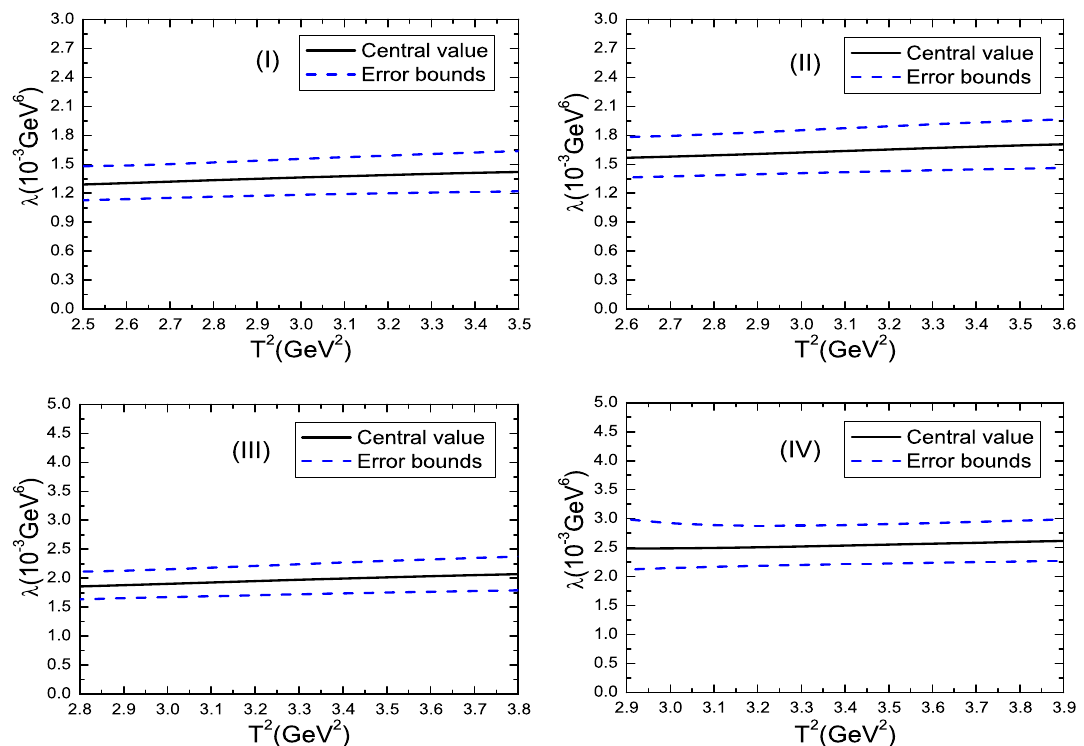
Fig. 6 The pole residues of the charmed pentaquark states with variations of the Borel parameters T 2 for the parameters B , where the (I), (II), (III) and (IV) correspond to the quantum numbers ( uuuc ¯ u , 3